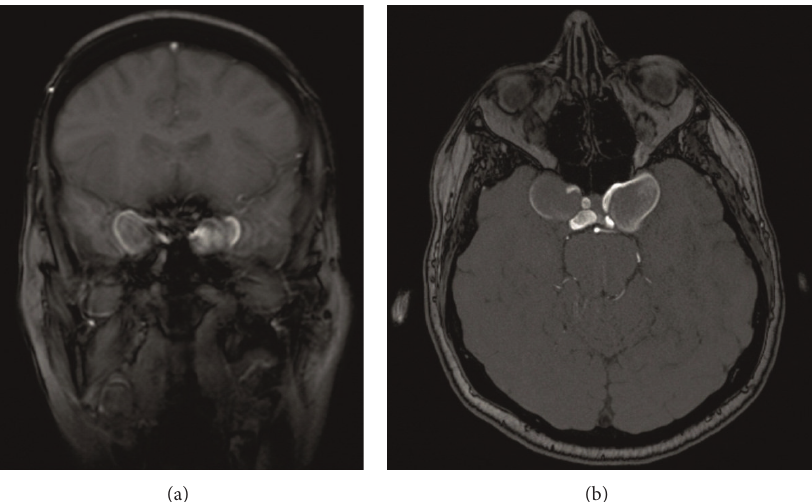
Figure1:T 1 weightedMRlofcoronal(a)and(b)axialslicesina26-year-oldpatientwithtransientdiplopiaandoculomotornervepalsyonthe left side. Two heterogeneously enhanced masses and an enhanced thin outer membrane can be recognized, indicating bilateral intracavernous carotid artery aneurysms.